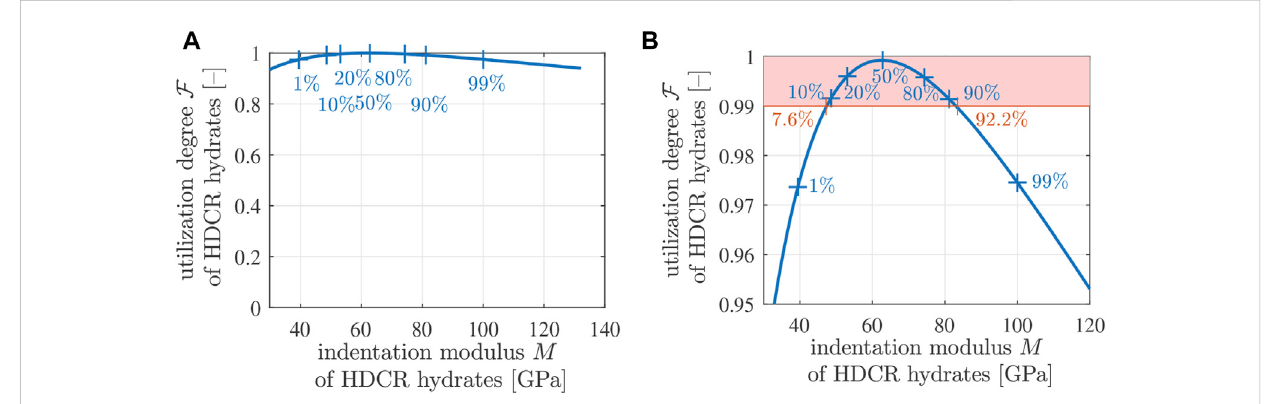
FIGURE 13 Degreeofutilization F (cid:1) | σ axi | / ( 2 C ) asafunctionoftheindentation modulus M forHDCR hydrates;the “ + ” symbols mark p -quantiles, withvalues of p given as percentage values: (A) overview, (B) detail.